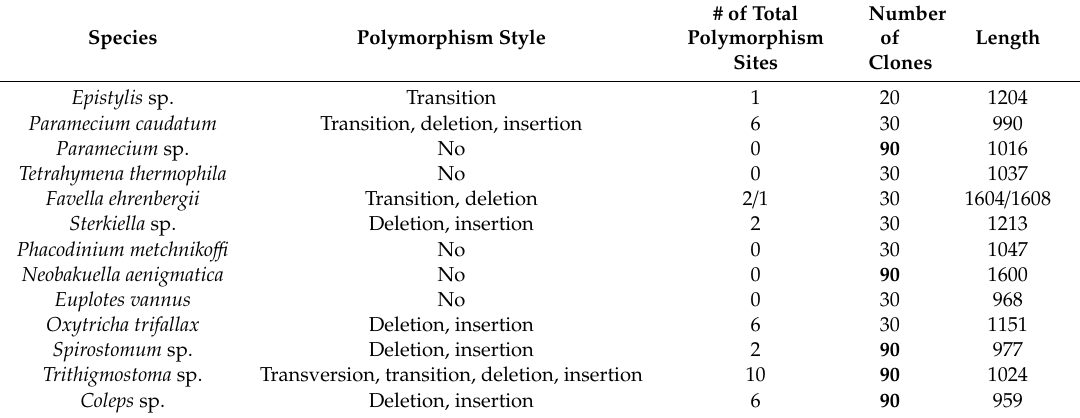
Deletion, insertion Deletion,